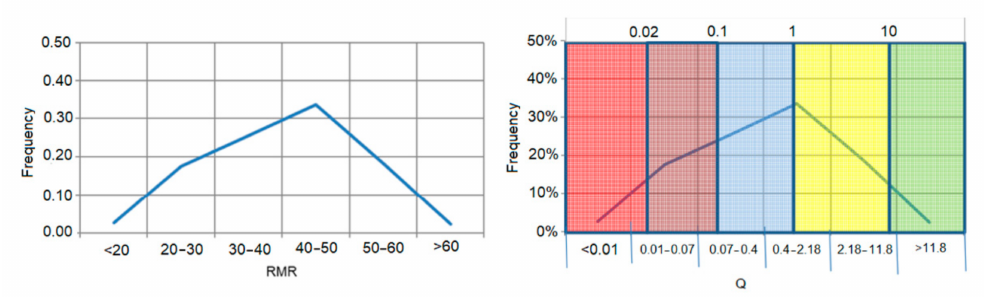
Figure 3. Distribution of RMR ( left ) and Q ( right ) values in the Arnotegi